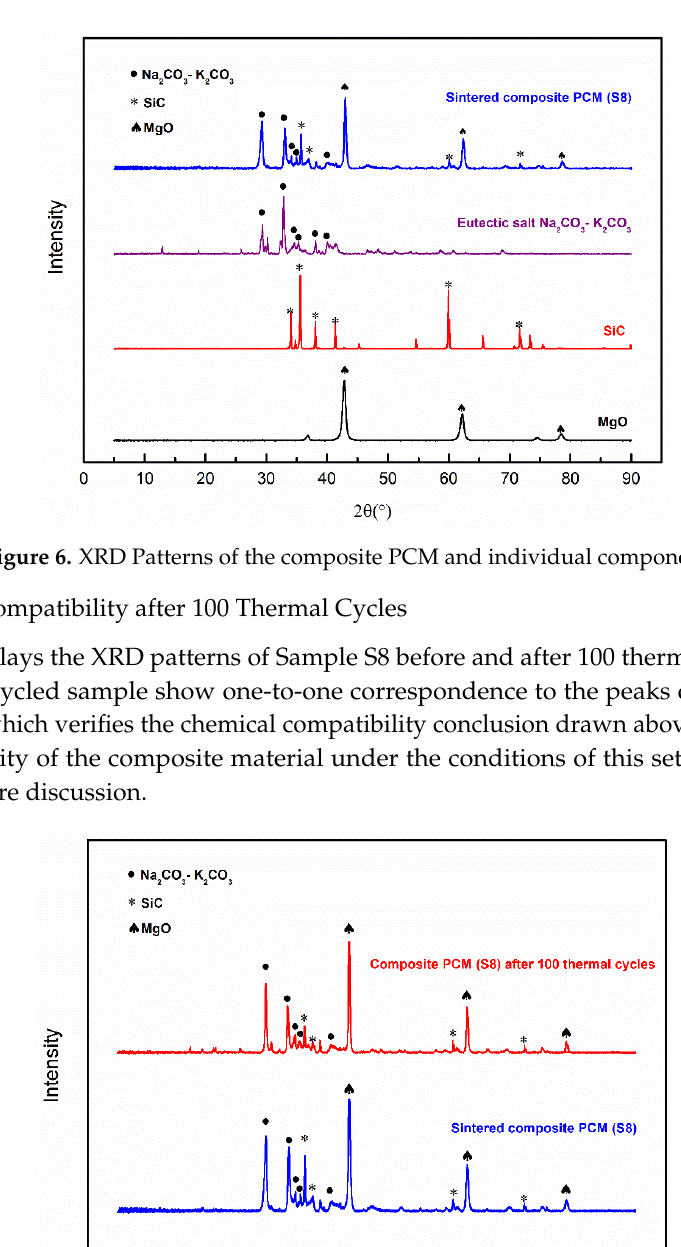
Figure 7. XRD patterns of Sample S8 with and without 100 thermal cycles.